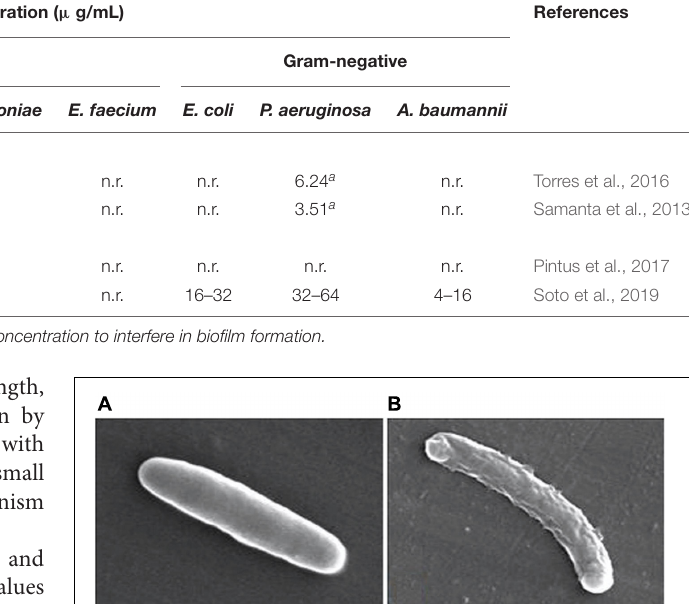
TABLE 3 | Antibiofilm activity of the gold(I) and gold(III) complexes. Compound